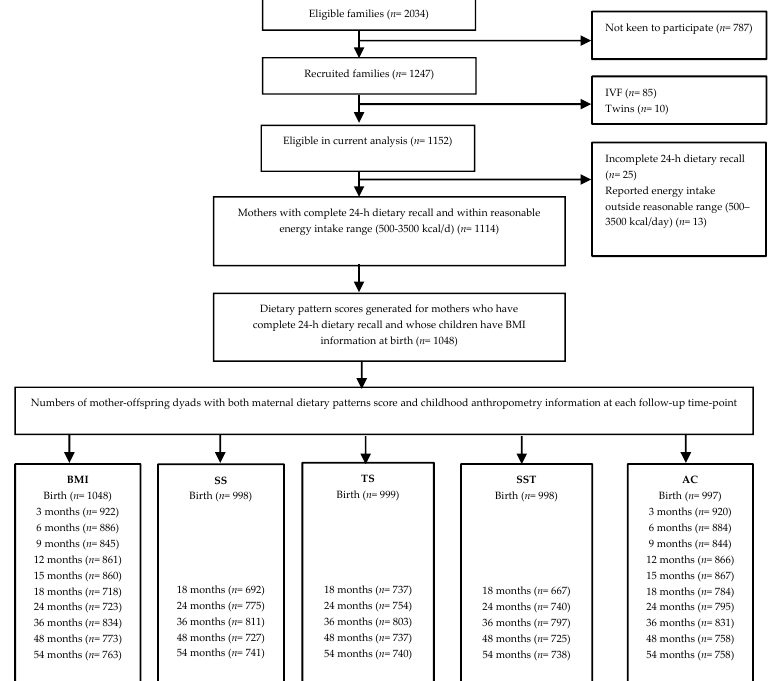
Figure 1. Participant flow chart. BMI, body mass index; SS, subscapular skinfold; TS, triceps skinfold; SST, sum of skinfolds thickness; AC, abdominal circumference.